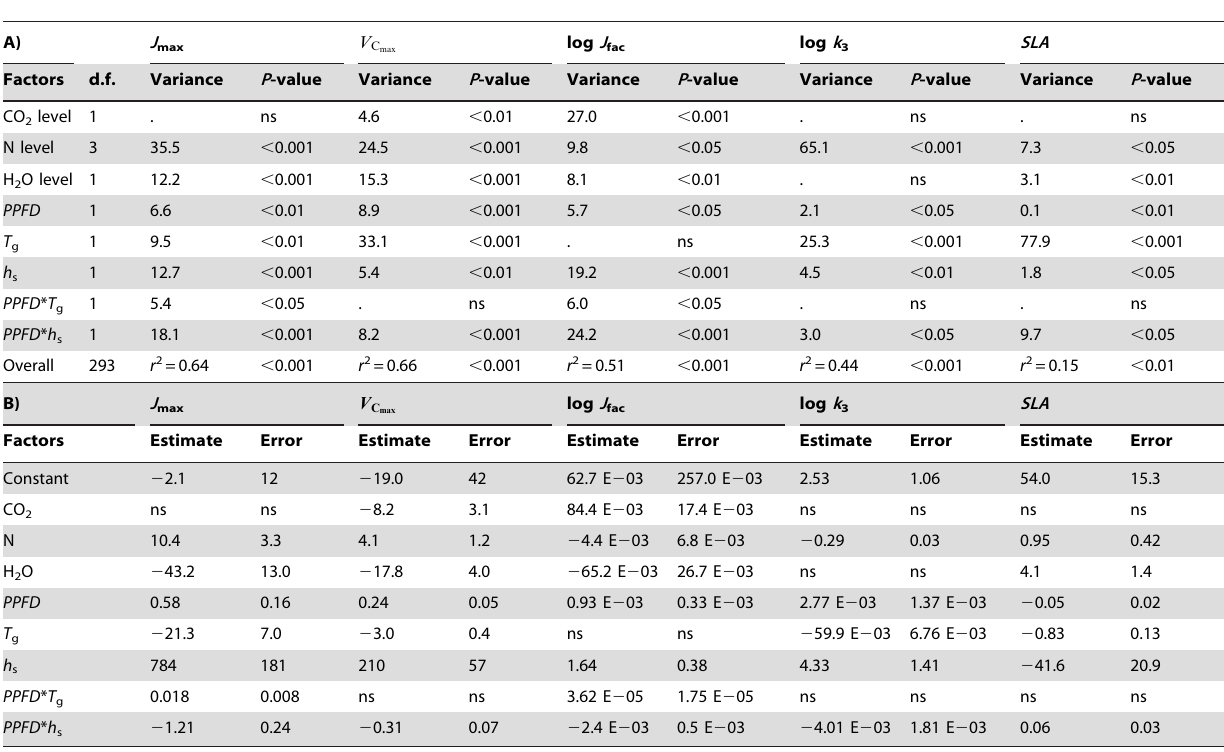
J max , J fac , k 3 and SLA . max log J fac log k 3 SLA max . . ns